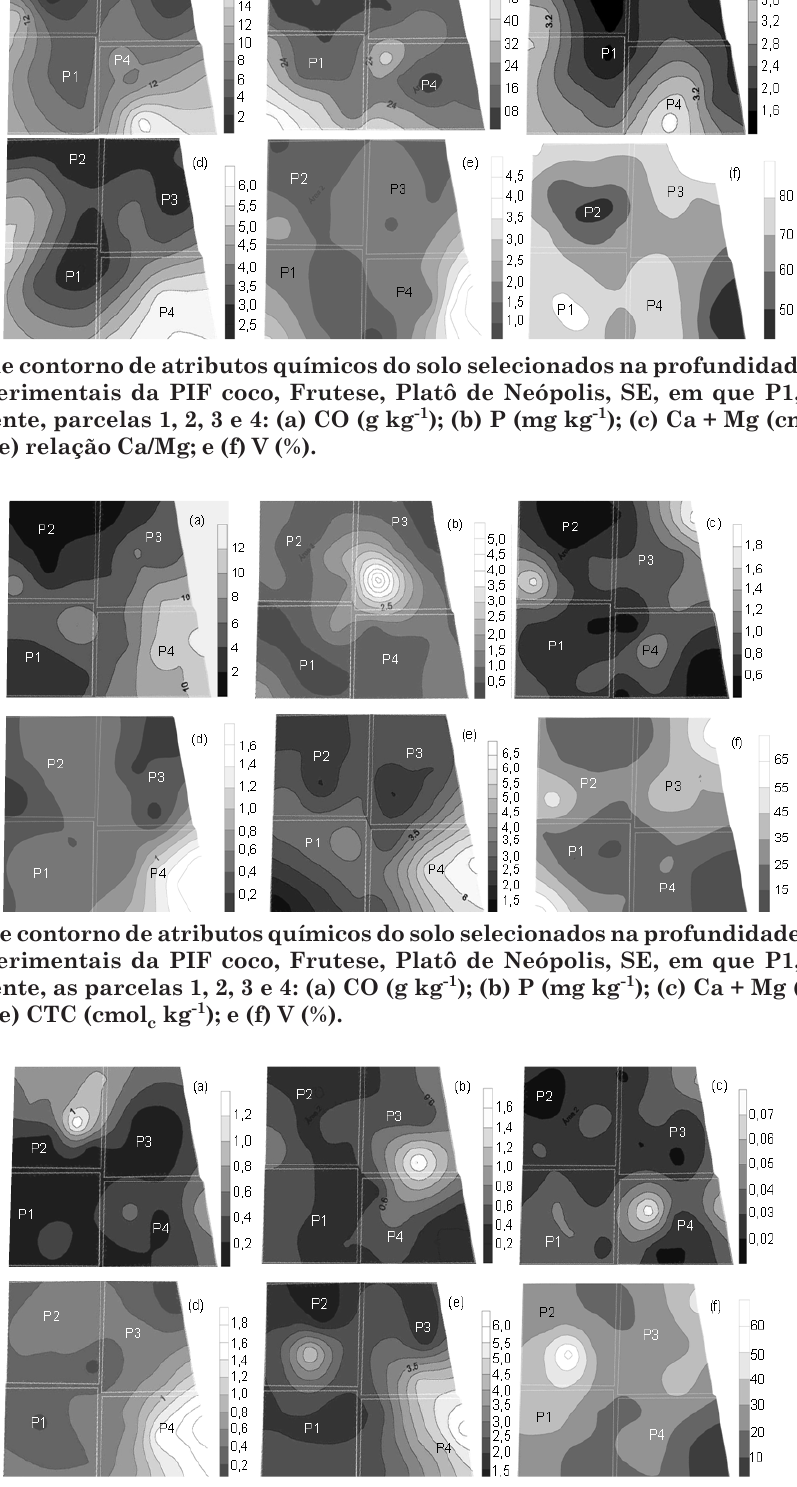
Figura 6. Mapas de contorno de atributos químicos do solo selecionados na profundidade de 100 a 130 cm, das parcelas experimentais da PIF coco, Frutese, Platô de Neópolis, SE, em que P1, P2, P3 e P4 são, respectivamente, as parcelas 1, 2, 3 e 4: (a) P (mg kg -1 ); (b) Ca + Mg (cmol (cmol kg -1 ); (e) CTC (cmol kg -1 ); e (f) V c c